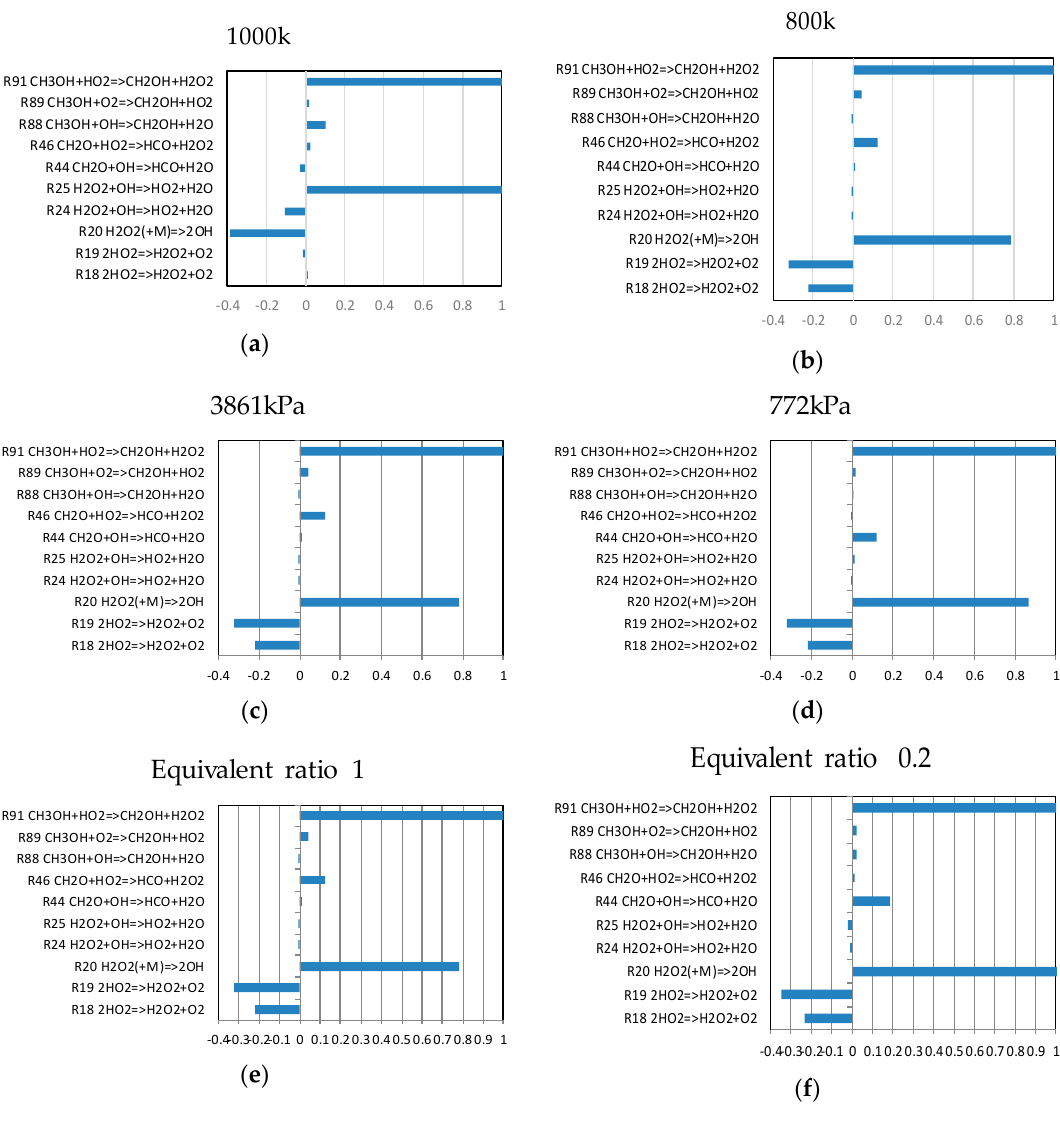
Figure 6. Reaction diagram of methanol hydroxyl sensitivity under different conditions. ( a ) tempature 1000 k; ( b ) tempature 800 k; ( c ) pressure: 3861 kPa; ( d ) pressure: 772 kPa. ( e ) equivalent ratio 1; ( f ) equivalent ratio